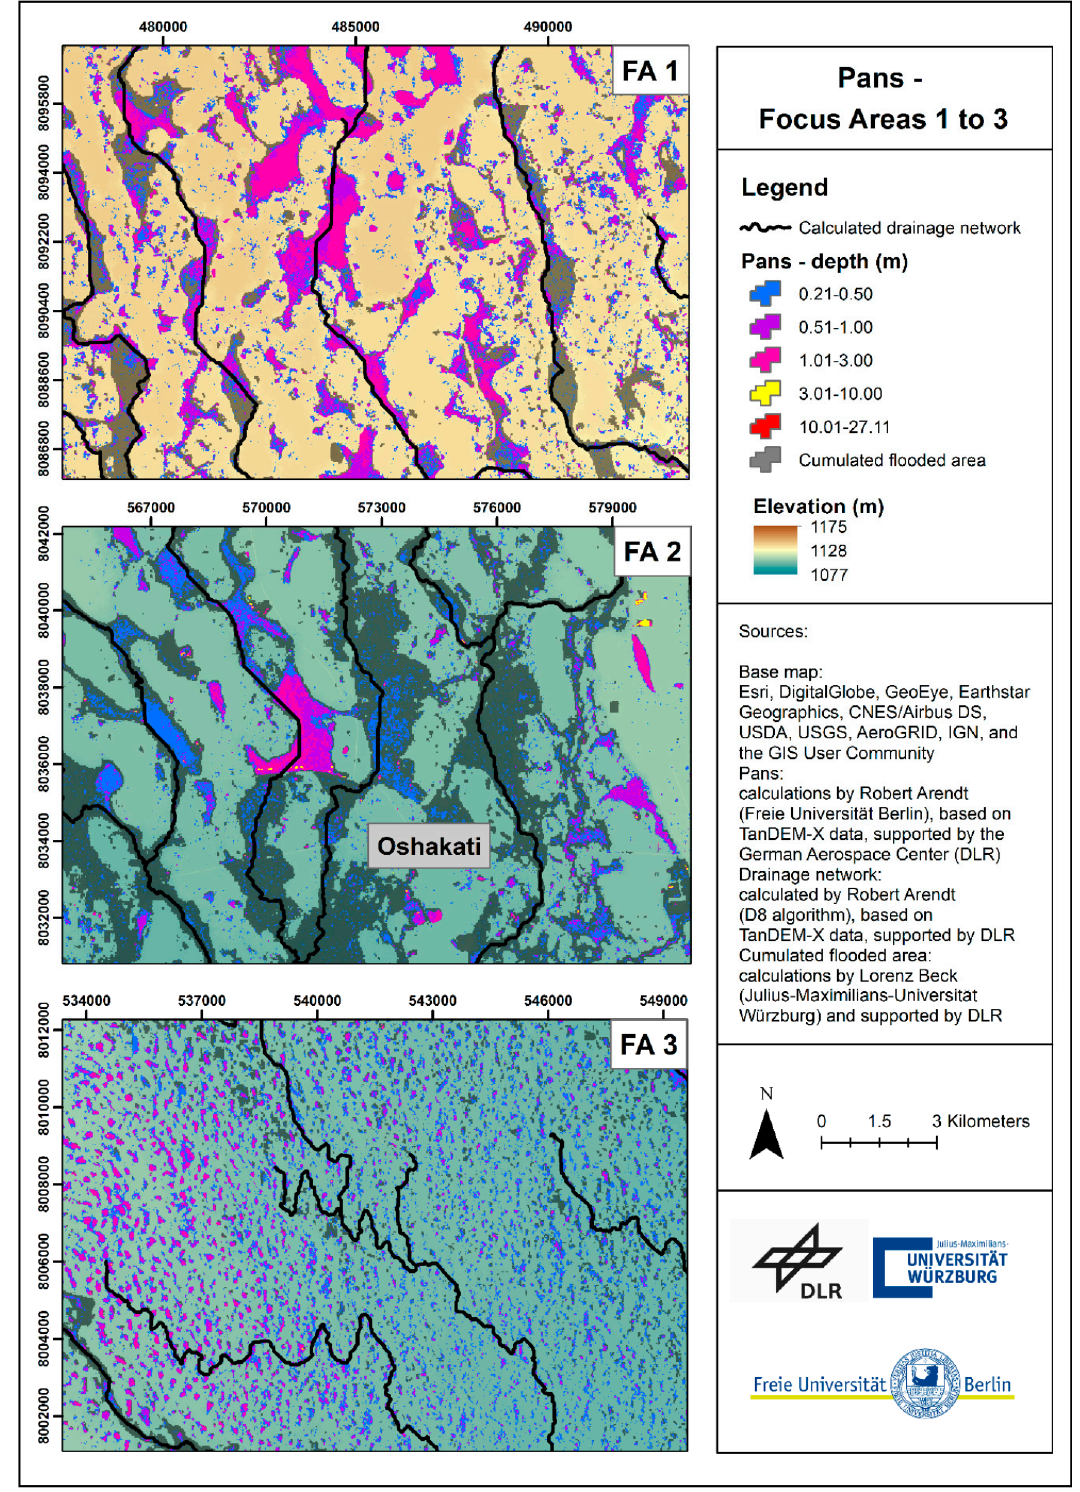
Figure 7. Pans in focus areas 1–3 in Angola and Namibia as shown in Figure 6. ( FA 1 ): Large and deep pans in the southwestern part of the Angolan Iishana-System; ( FA 2 ): Fewer but still large pans around the town of Oshakati in the southeastern part of the Namibian part of the Iishana-System, pans highlighted in yellow represent borrow pits; ( FA 3 ): Thousands of small and isolated pans in the southern part of the Iishana-System in